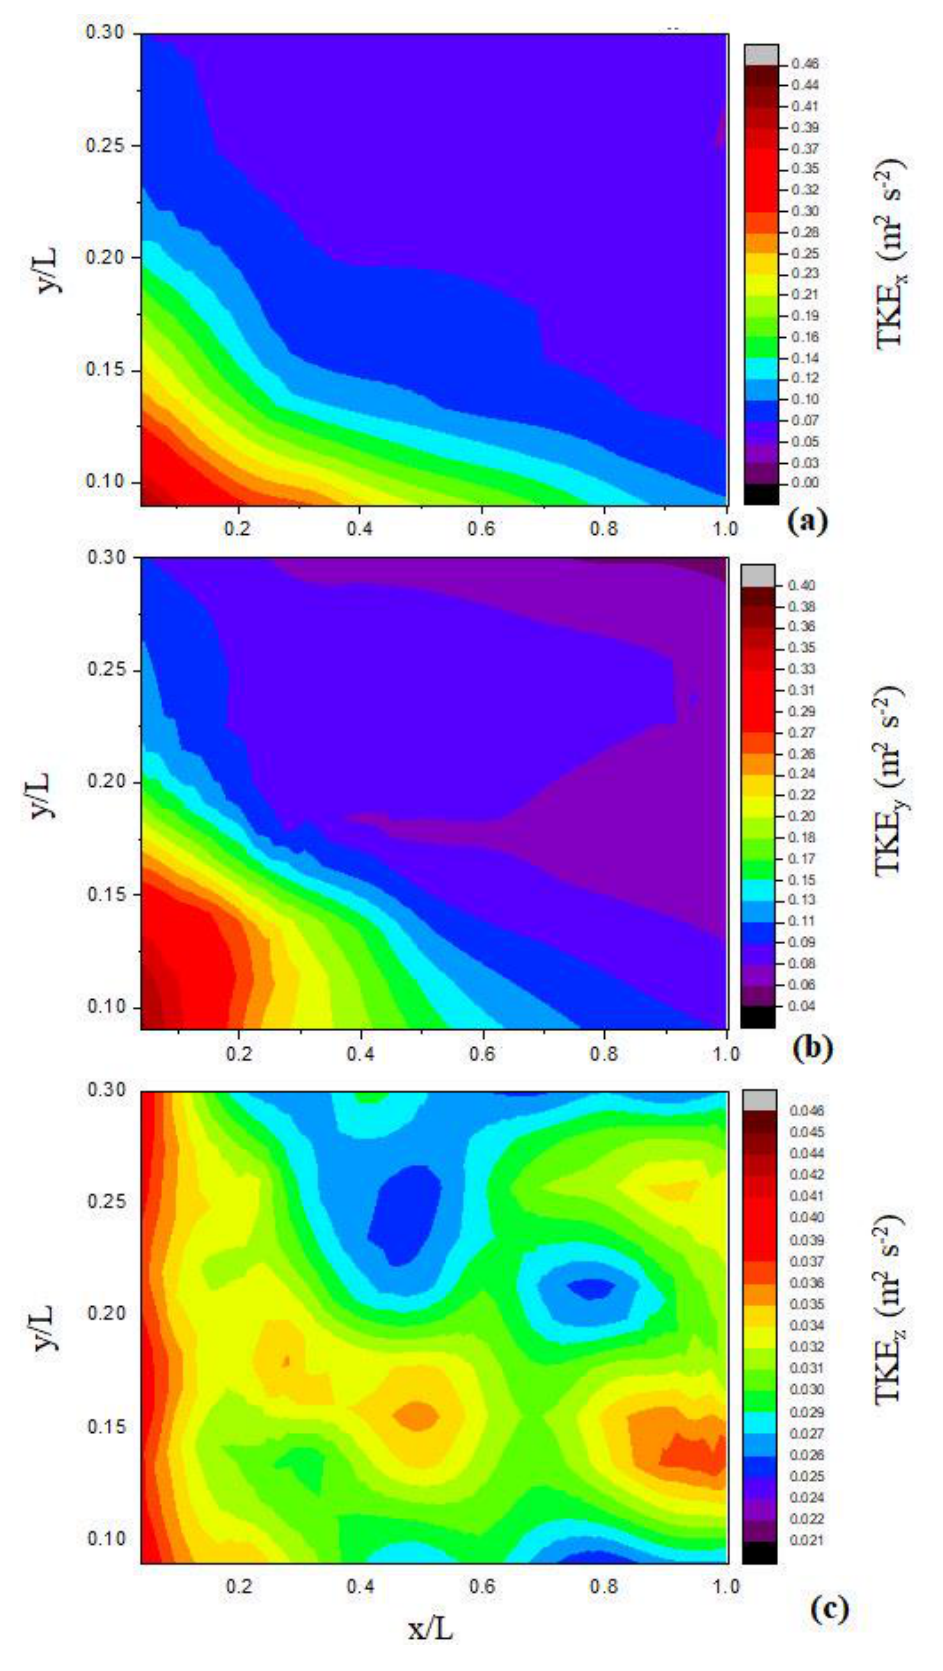
Figure 6. Contour maps of depth-averaged ( a ) TKE x , ( b ) TKE y , and ( c ) TKE z for the experimental run 6R.